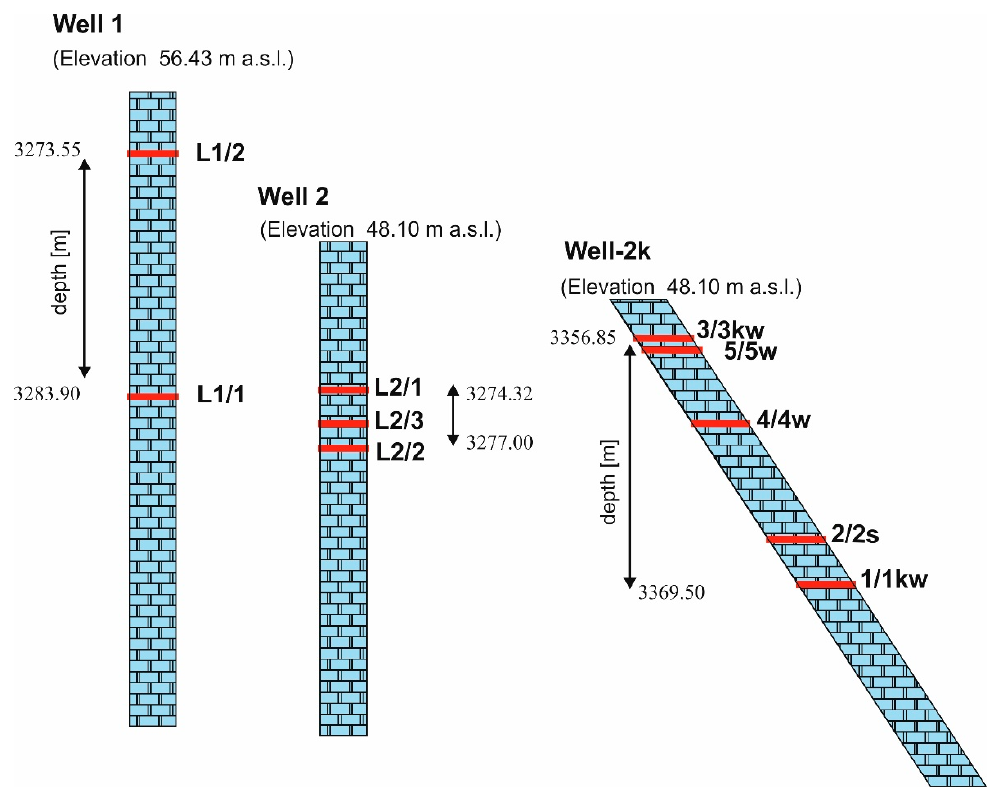
Figure 2. Location of samples from well profile parts.